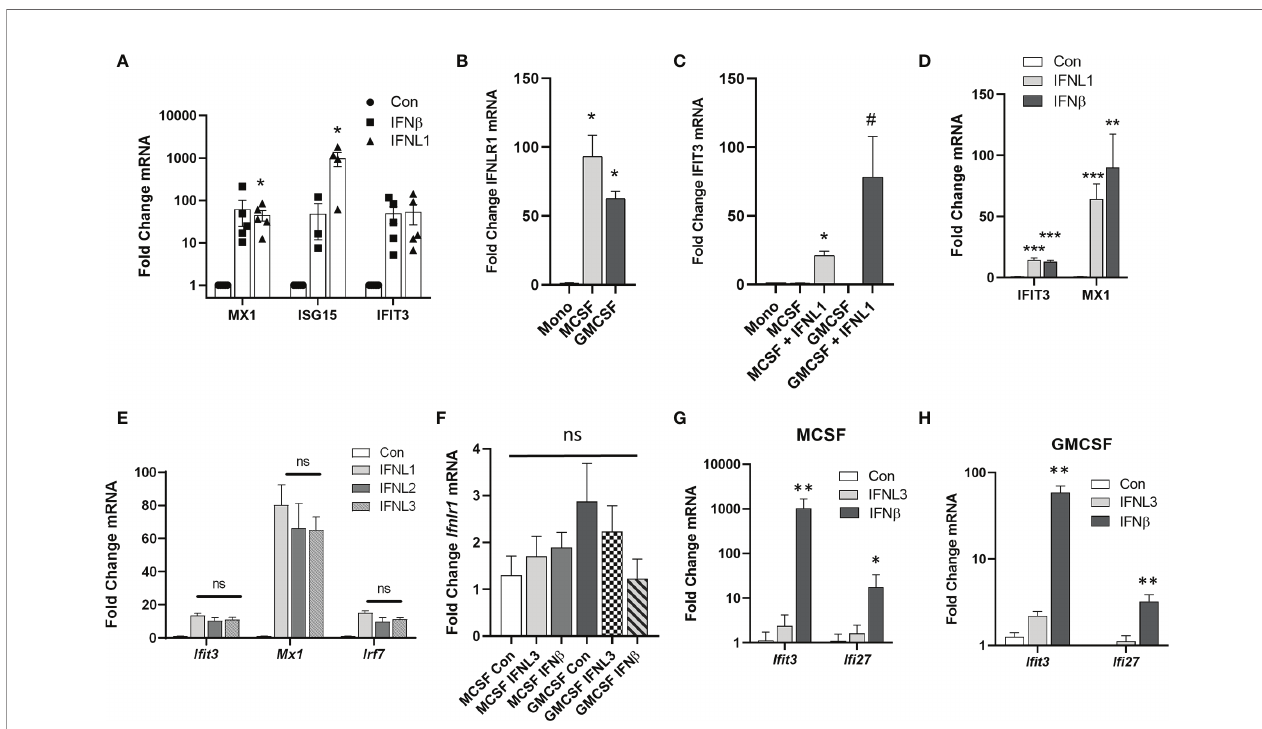
FIGURE 3 | Differentiation of monocytes to macrophages increases IFNLR1 expression and function. HAMs were cultured overnight followed by treatment with IFN b (20 ng/mL) or IFNL1 (50 ng/mL). RNA was isolated at 24 h post treatment and interferon stimulated genes (ISGs) were measured (HAMs isolated from 4 donor lungs, n=5,5,3,4,5,5) (A) . Human CD14 monocytes were differentiated to macrophages with M-CSF or GM-CSF (50ng/mL, 7 days). We then measured IFNLR1 mRNA expression (B) and the induction of the ISG IFIT3 by qRT-PCR following treatment with or without IFNL1 (C) . ISG production after treatment with either IFN b (20 ng/mL) or IFNL1 (50 ng/mL) (D) . Representative of 3 independent experiments, n= 3,3,6) (B – D) . We measured the expression of ISGs in response IFNL1, IFNL2, and IFNL3 (50 ng/mL) to con fi rm that all three isoforms are active in GM-CSF macrophages. n=2 independent experiments, n= 5,5,5,6 (E) . We generated murine bone marrow derived macrophages (BMDMs) after treatment with either M-CSF or GM-CSF (50 ng/mL) and examined changes in IFNLR1 mRNA expression, ns, not signi fi cant (F) . We also measured the induction of the ISGs IFIT3, MX1, and IRF7 in response to IFNL3 (100 ng/mL) or IFN b (20 ng/µL) in M-CSF (G) and GM-CSF (H) macrophages. n= 3 independent experiments, At least n=5 per group (G – H) . Multiple T-test with Holm-Sidak correction (A – H) . *p < 0.05 Mono (B) *p < 0.05 vs. M-CSF, # p < 0.05 vs. M-CSFGM-CSF (C) *p < 0.05, **p < 0.01, ***p < 0.001, vs. Control (Con) (D – H)